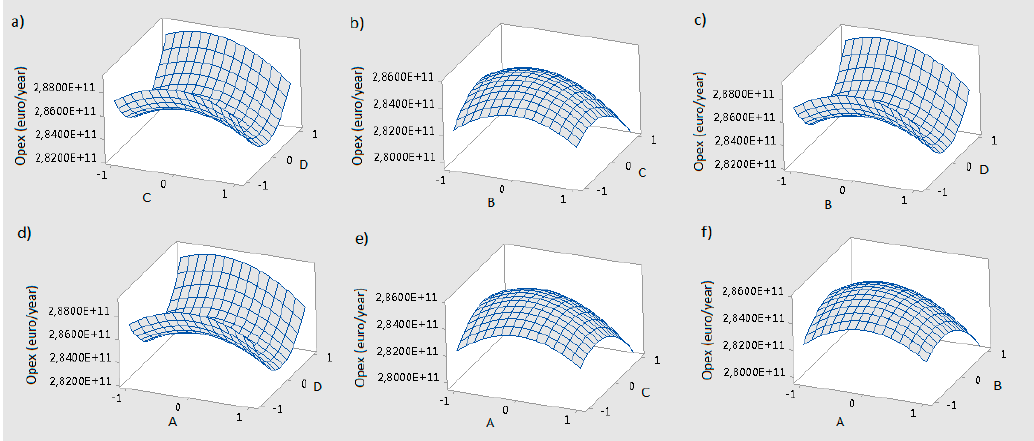
Figure 6. Response surface plots for OPEX (€/year) as a function of: ( a ) factor C and D ; ( b ) factor B and C ; ( c ) factor B and D ; ( d ) factor A and D ; ( e ) factor A and C ; ( f ) factor A and B . (Hold values: A = B = C = D = 0) (factor A = flue gas inlet temperature, factor B = column pressure, factor C = carbon dioxide composition in flue gas, factor D = height of the absorber).